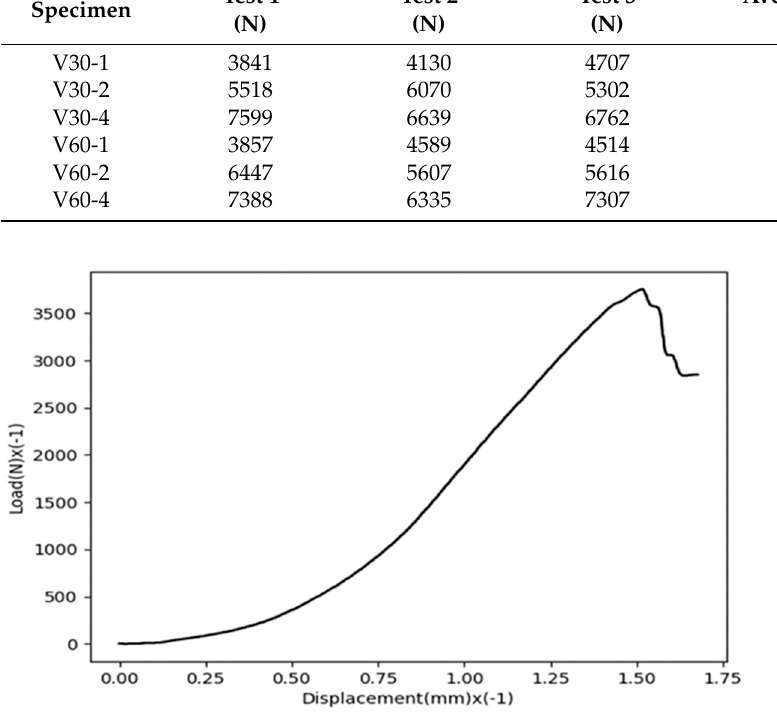
Figure 7. Load-displacement curve of a notched AA7075-AA6061 specimen with a notch angle of 30 ° and ρ = 1 mm. Table 2. LBC (maximum load) values obtained in the fracture tests of AA7075-AA6061 weld material.